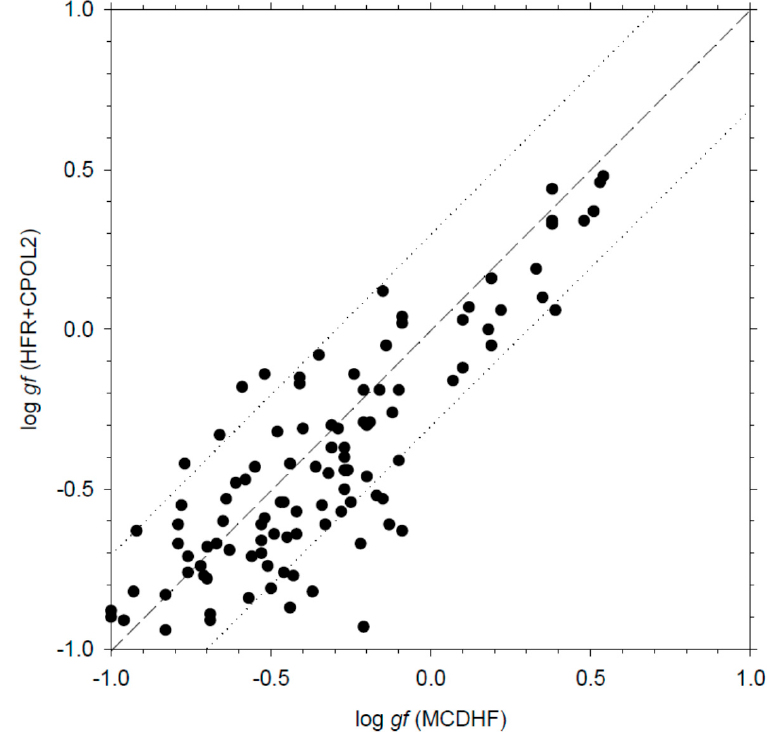
Figure 4. Comparison between the oscillator strengths (log gf ) computed in the present work using the HFR+CPOL2 and the MCDHF models. The dashed line corresponds to a perfect agreement while the dotted lines correspond to a discrepancy of a factor of two on the gf ‐ values.